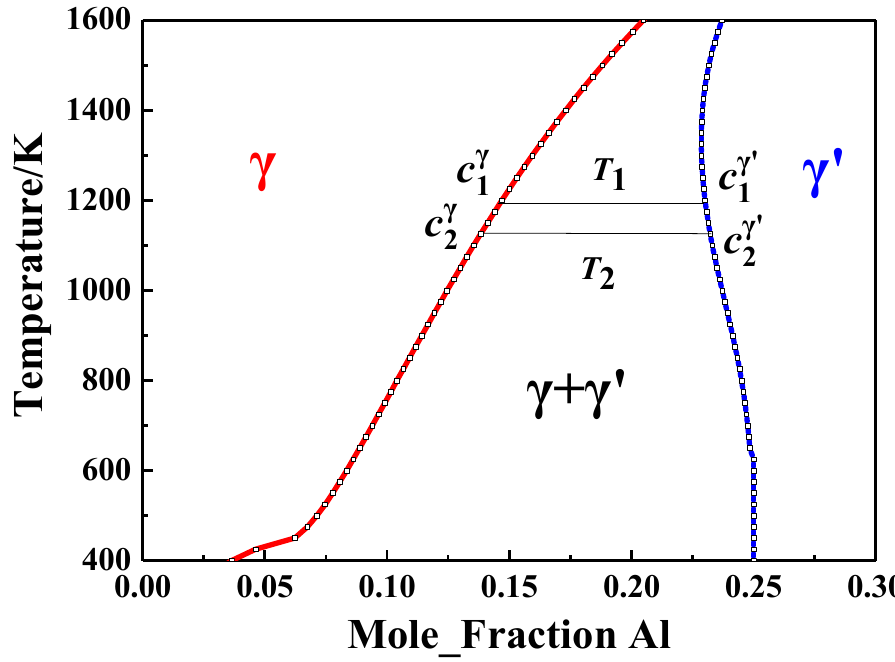
Figure 1. The Ni–Al partial binary phase diagram.